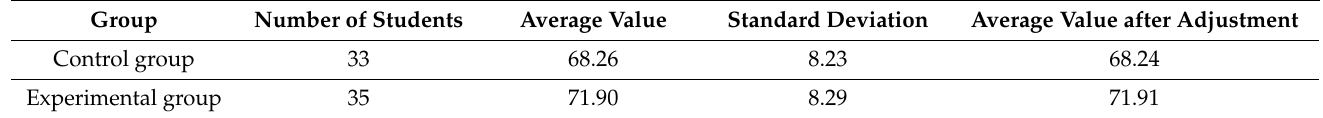
Table 11. Recapitulation sheet of statistics in overall learning effectiveness of basic electricity practical. Group